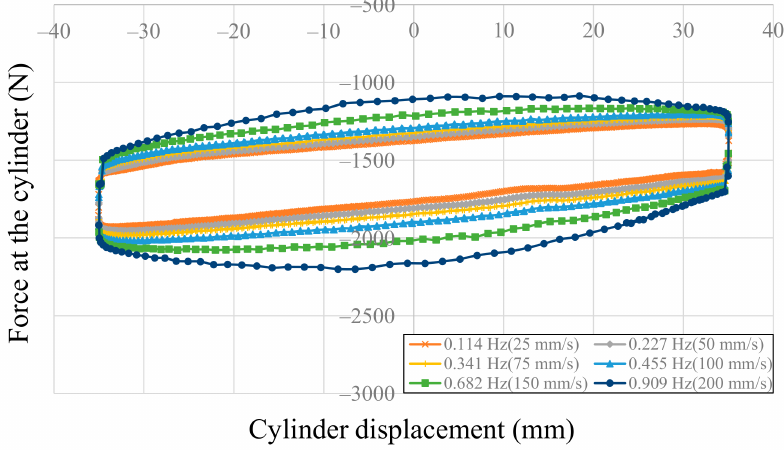
Figure 8. Force-velocity results from test when applied valve current was 1580 mA (command